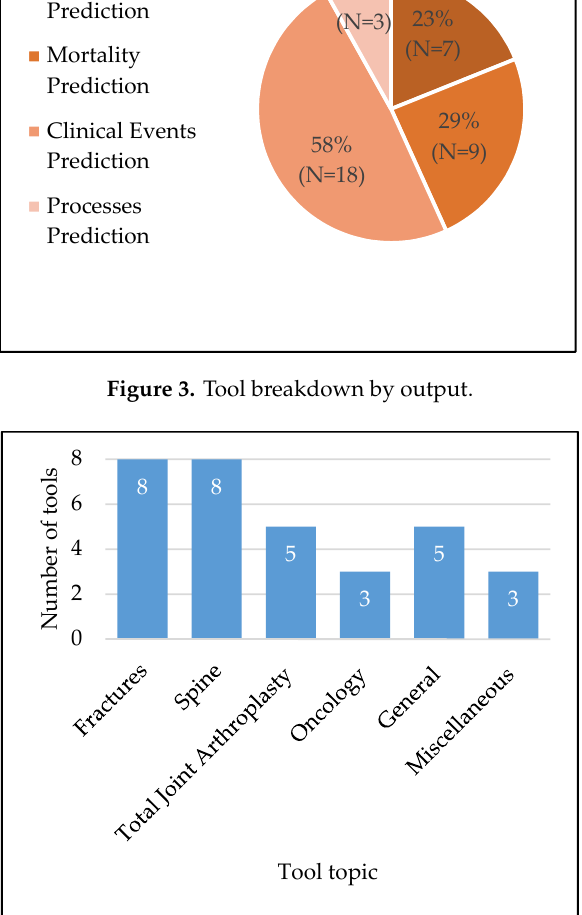
Figure 4. Tool breakdown by orthopedic category.